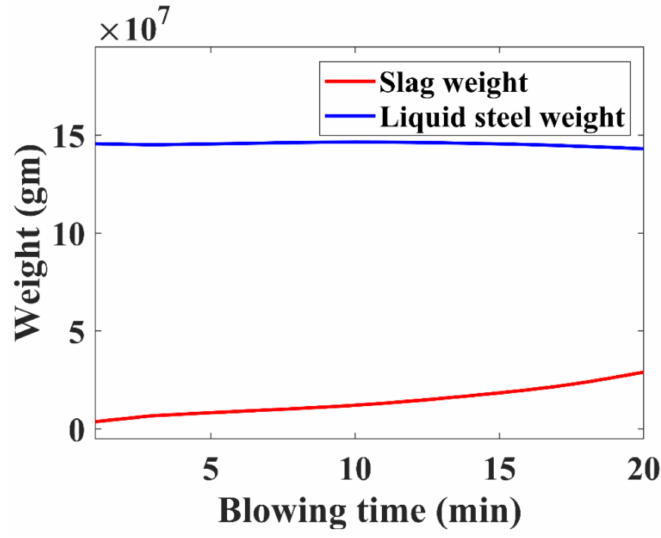
Figure 5. Weight variations in liquid steel (blue) and liquid slag (red) for inialpha value 0.06 with blowing time.